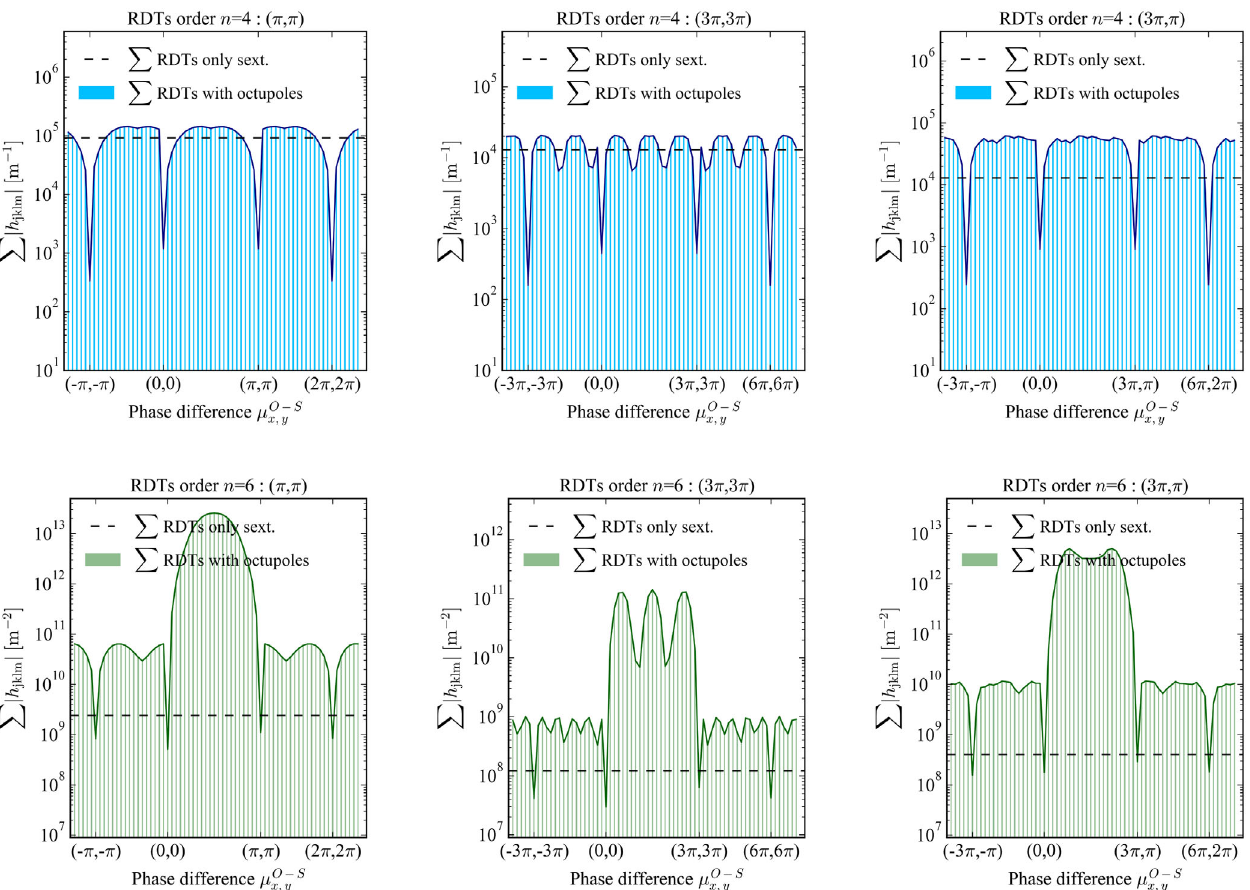
FIG. 2. Top plot: Sum of all fourth order geometrical RDTs (order n ¼ 4 ) as function of the position of the octupole triplet with respect to the sextupoles. The three RDTs contributing to linear ADTS are not included in the sum as they are fully cancelled at each position; Bottom plot: Sum of all sixth order geometrical RDTs ( n ¼ 6 ), including the amplitude dependent terms driving the second order ADTS, as function of the position of the octupole triplet with respect to the sextupoles. From left to right, the scan has been applied for Δ μ S π ; π Þ , ( 3 π ; 3 π ), and ( 3 π ; π ). The value of the RDT sum drops drastically at the sextupole location ( m ¼ 0 ) and at x;y ¼ ð m × Δ μ S Δ μ O − S x;y ¼ x;y . The black dashed lines show the sum value of the sextupole contribution